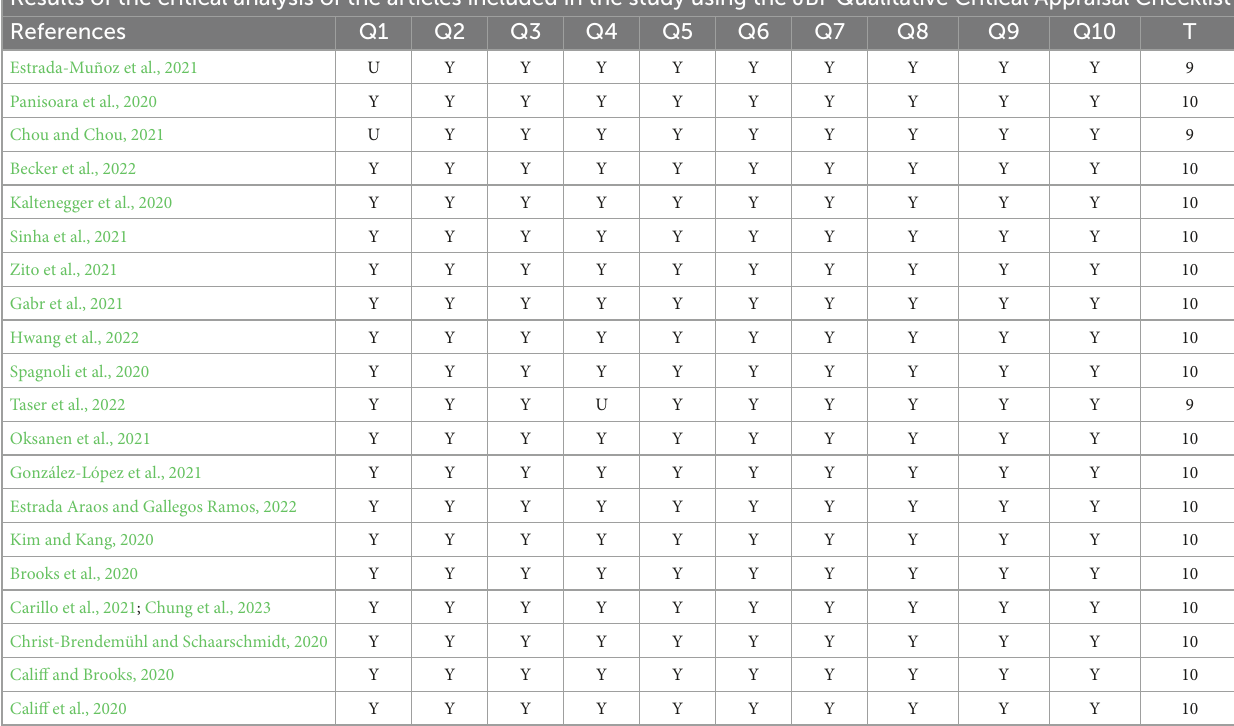
TABLE 2 Table of articles analyzed using the JBI-Qualitative Critical Appraisal Checklist. Results of the critical analysis of the articles included in the study using the JBI-Qualitative Critical Appraisal